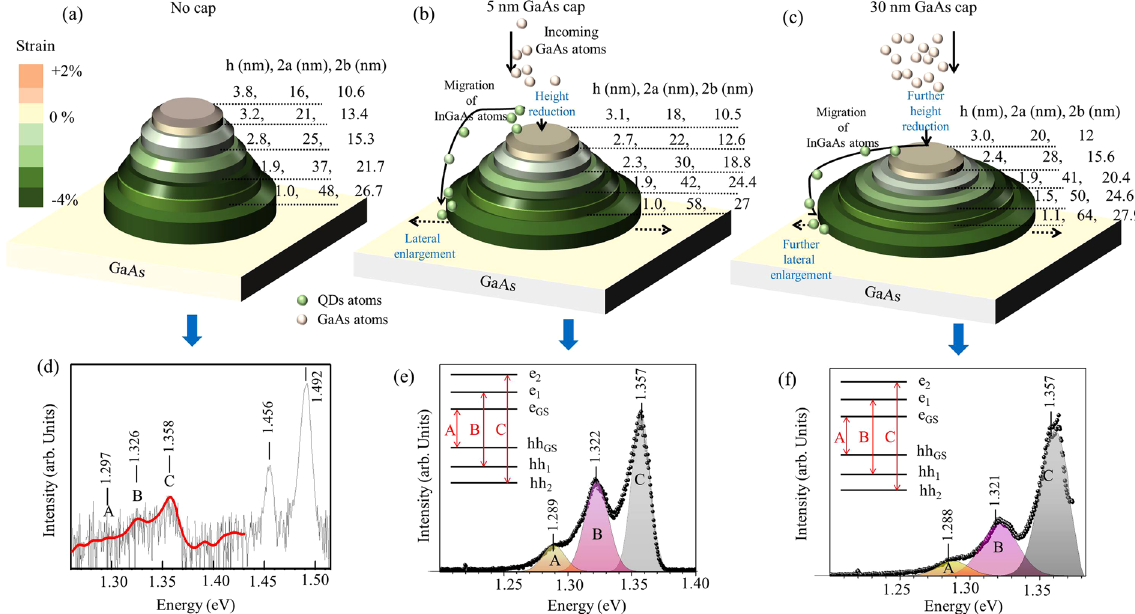
Figure 4. Iso-strain elliptical discs are stacked one over another to form elliptical-lens QD as obtained from radial and angular scans of GID measurements on ( a ) uncapped, ( b ) 5 nm capped, and ( c ) 30 nm capped QDs on GaAs (001) substrate. Color bar indicates the strain values for each elliptical disc. Lateral and vertical dimension of each elliptical disc is indicated as 2a (major axes), 2b (minor axes) and h (height from GaAs substrate). PL response of ( d ) uncapped (red line, smoothed data for guide to eye to improve clarity), ( e ) 5 nm (black line) and ( f ) 30 nm (red line) GaAs capped InGaAs QDs. ‘A’, ‘B’ and ‘C’ are indicates ground and higher excited states excitonic transition lines of QDs and higher energy peaks are related to wetting layer excitonic transition